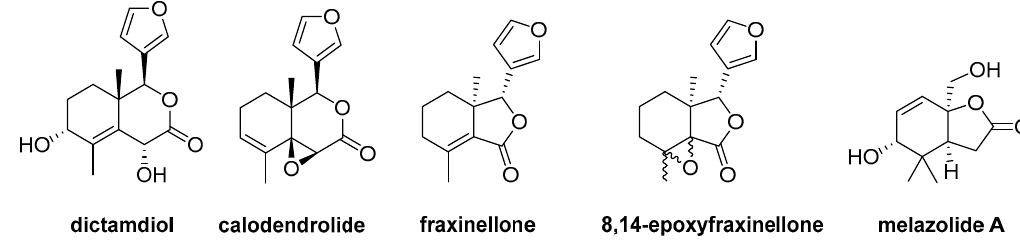
Figure 3. Chemical structures of some naturally-occurring degraded limonoids.